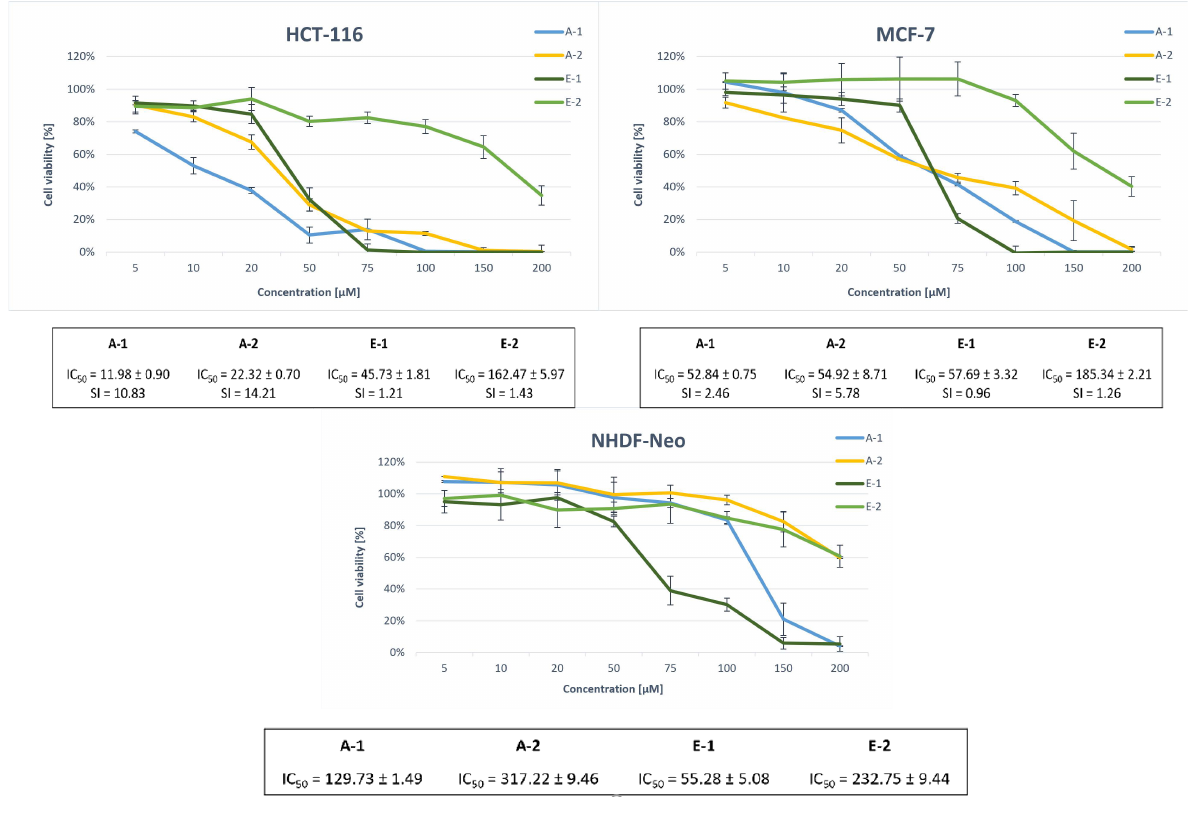
Figure 3. Comparison of the viability of HCT-116, MCF-7, and NHDF-Neo cells treated with different concentrations of the tested glucoconjugates: A-1 , A-2 , E-1 , and E-2 . Cell viability was measured by the MTT test. Data are presented as the mean ± standard deviation ( n =